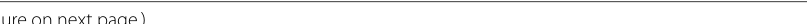
(See figure on next page.) Fig. 5 a Alteration of mitochondrial morphology by IO-cubes and IO-clusters treatment. Cells were stimulated with IO-cubes or IO-clusters (100 µg/mL) for 24 h and labeled with MitoTracker ® green. Treatment with 20% ethanol for 20 min served as a positive control. Nuclei were labelled with hoechst 33342 nuclear stain (blue). Labeled cells were then imaged using high-resolution spinning disk confocal microscopy (Spin SR, Olympus). b Cells were stimulated with IO-cubes or IO-clusters (100 µg/mL) for 24 h and analyzed by Western immunoblotting. Actin-control of equal protein loading. Cells treated with 2 μM staurosporine for 3 h served as a positive control. c Densitometric quantification of membrane-bound lipidated form of LC3. Average band intensity after Western blotting ( b ). Cells were treated as in b . Data are expressed as